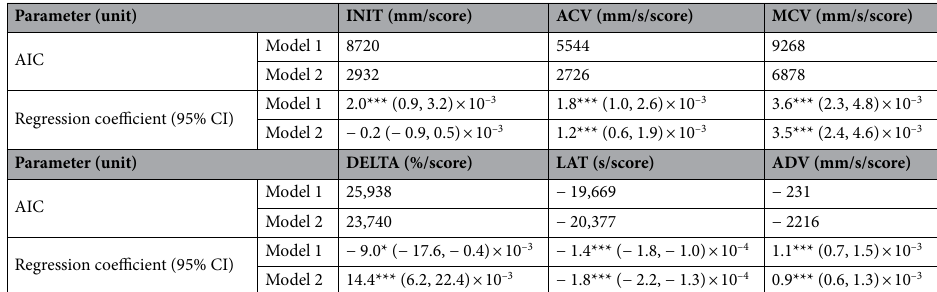
Table 2. Comparison of Akaike’s information criterion and regression coefficients between the two models for pupillary light reflex parameters. ACV average constriction velocity, ADV average dilation velocity, AIC Akaike’s information criterion, CI confidence interval, DELTA constriction ratio, INIT initial pupil size, LAT constriction latency, MCV maximum constriction velocity. * p < 0.05; ** p < 0.01; *** p <